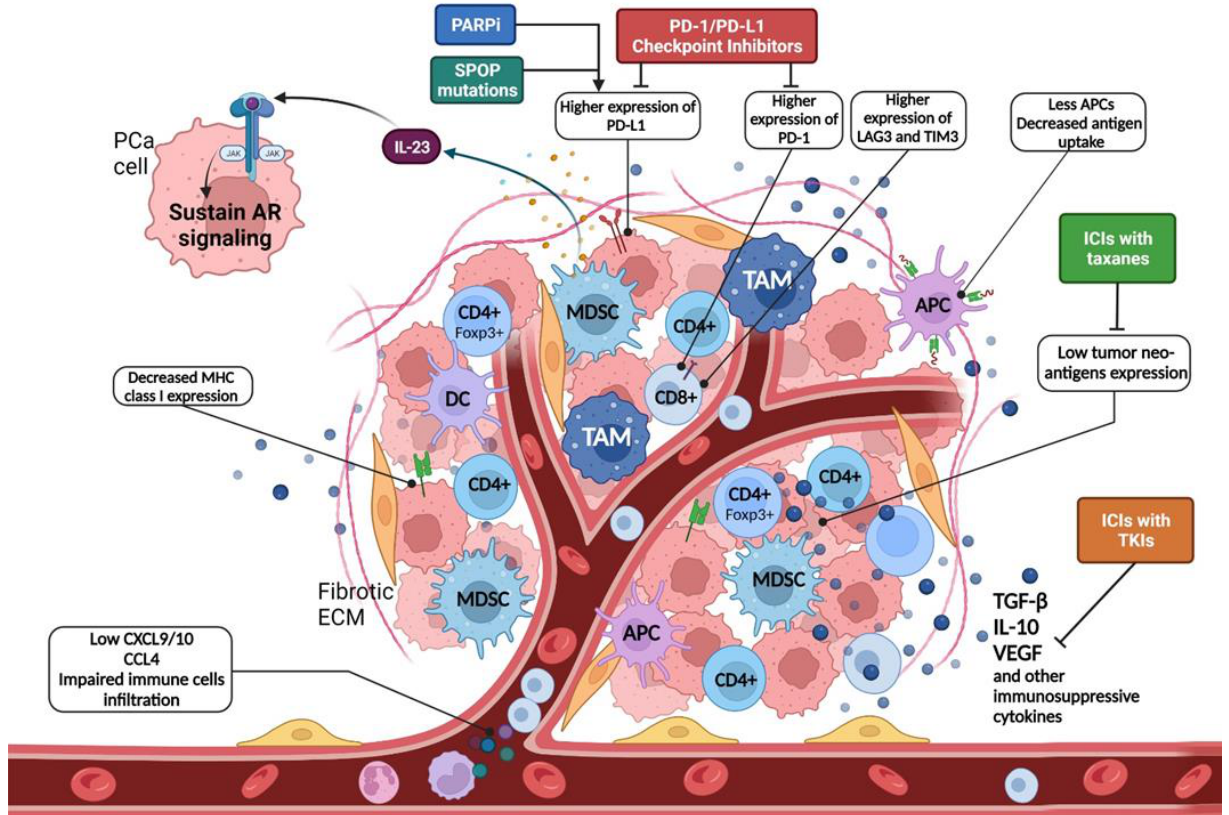
Figure 1. Immunosuppressive tumor microenvironment and how we can overcome it. PARP-i poly(ADP-ribose) polymerase inhibitor, PD-1 programmed cell death-1, PD-L1 programmed cell death ligand 1, SPOP speckle type BTB/POZ protein, IL interleukin, LAG3 lymphocyte activating 3, TIM3 T-cell immunoglobulin domain and mucin domain 3, APC antigen-presenting cell, PCa prostate cancer, AR androgen receptor, ICIs immune checkpoint inhibitors, TAM tumor-associated macrophage, MDSC myeloid-derived suppressor cell, DC dendritic cell, MHC major histocompatibility complex, TKIs tyrosine kinase inhibitors, ECM extracellular matrix, TGF transforming growth factor, VEGF vascular endothelial growth factor, CXCL chemokine (C – X – C motif) ligand, CCL chemokine ligand.